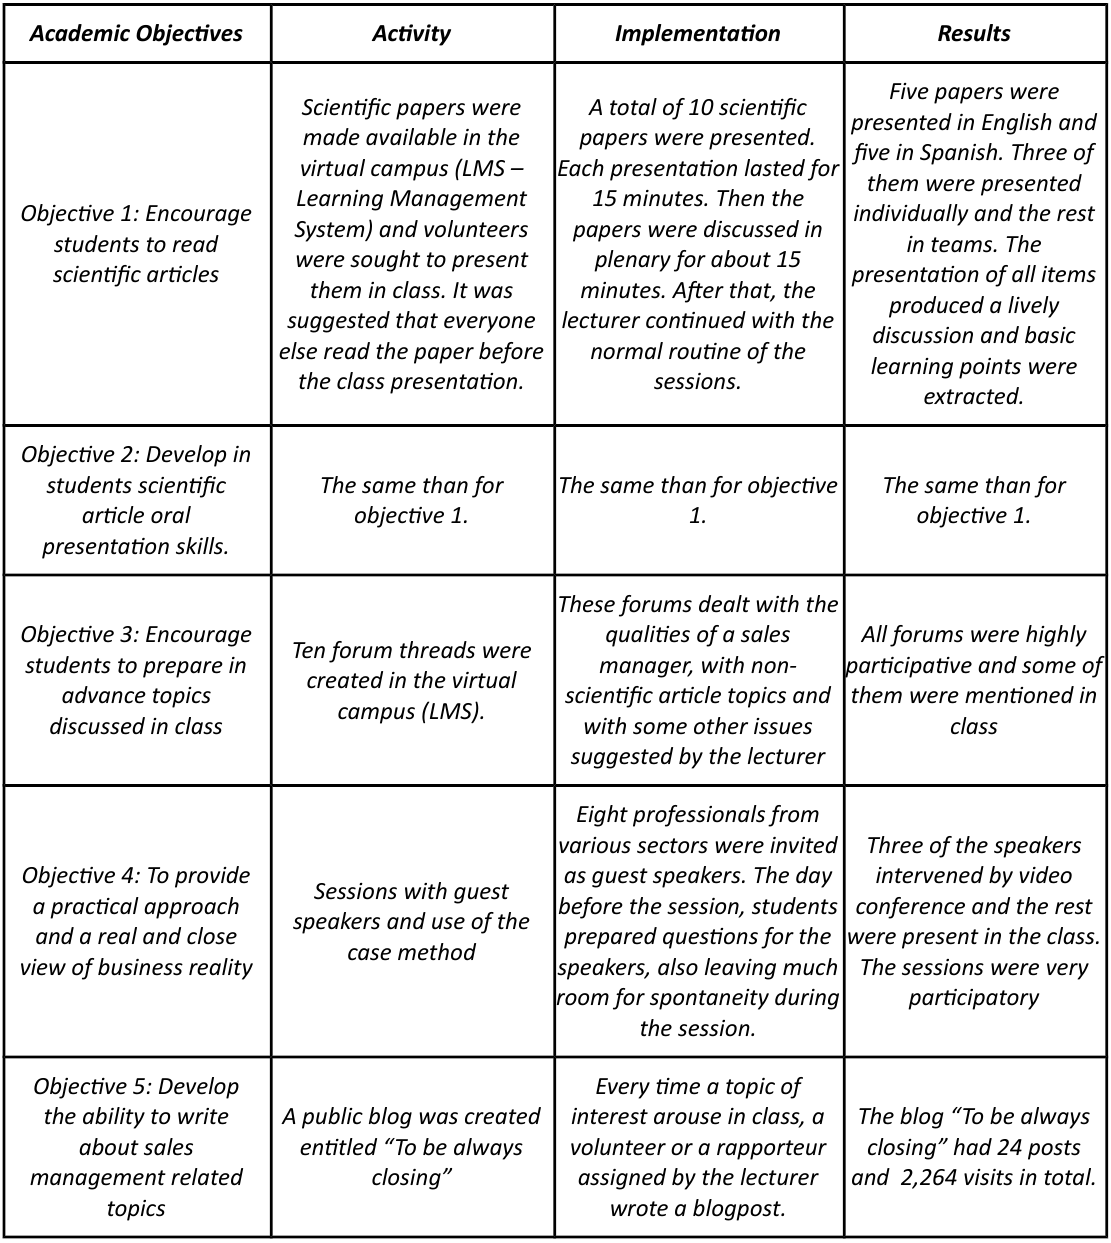
Table 1. Academic objectves of the pilot